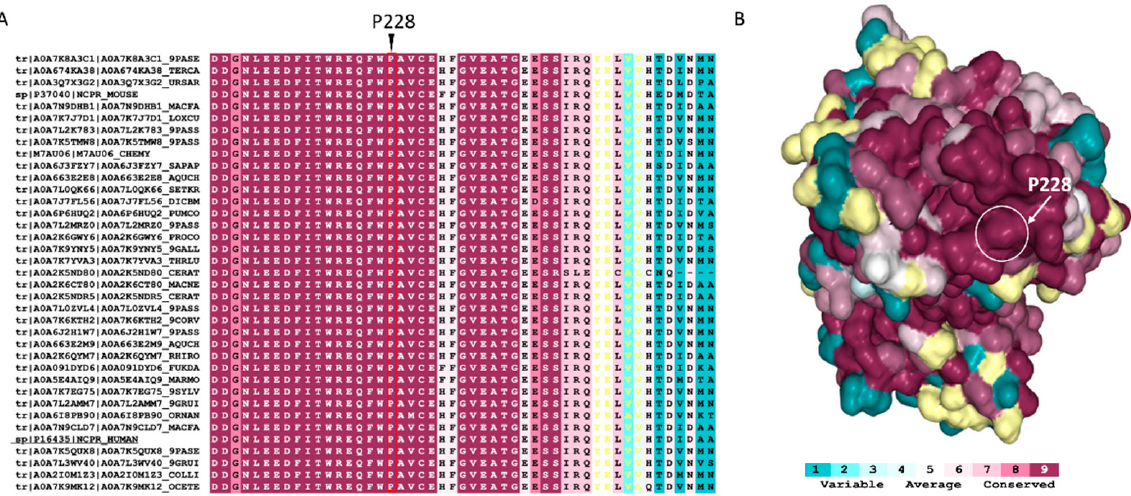
Figure 3. ConSurf analysis of POR (PDB # 5FA6) evolutionary conservation profile. ( A ) A segment (residues 210–258) of the multiple-sequence alignment of 250 POR homologues across species. Position 228 is indicated with an arrow; the P228 has a score of 9 being classified as highly conserved. The alignment is coloured according to the ConSurf conservation colour bar (details below). ( B ) POR structure is illustrated as a surface model; the amino acids are coloured according to the conservation scores. The colour bar varies from (1) cyan, meaning variable, to (9) maroon, meaning conserved. The amino acids coloured yellow have not been classified due to insufficient data.